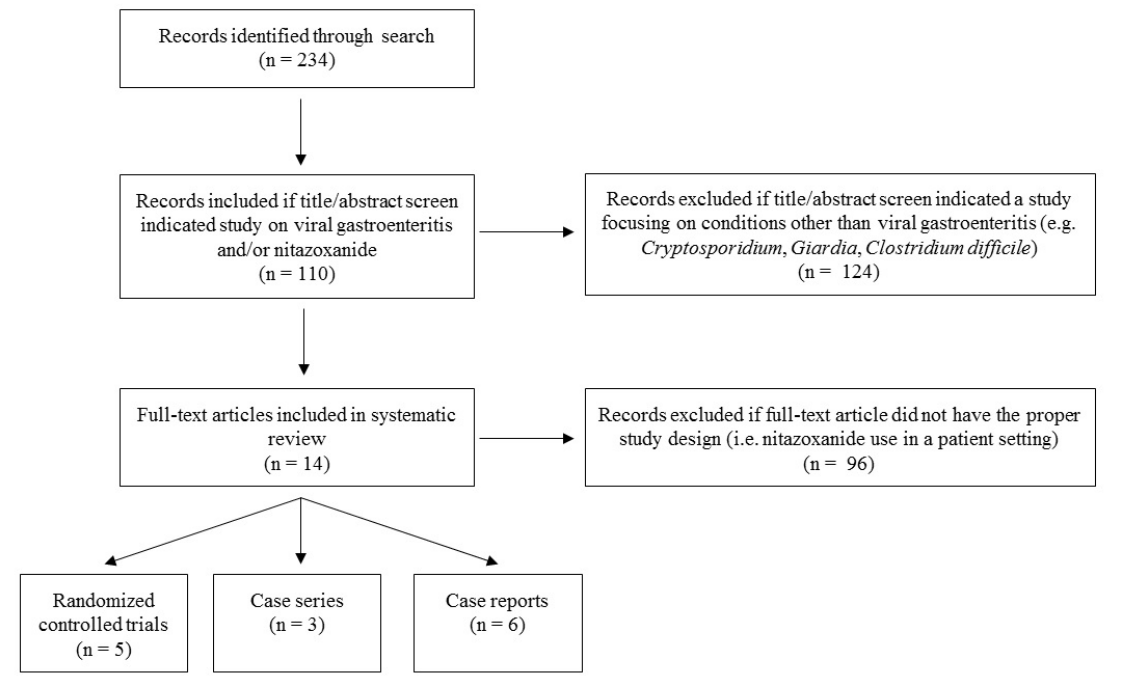
Figure 1. Flow Diagram Depicting Inclusion and Exclusion of Various Studies. Records were identified using the following databases: Ovid Medline In-Process & Other Non-Indexed Citations, Ovid MEDLINE, Ovid EMBASE, Ovid Cochrane Central Register of Controlled Trials, Ovid Cochrane Database of Systematic Reviews, and Scopus from 1946 to